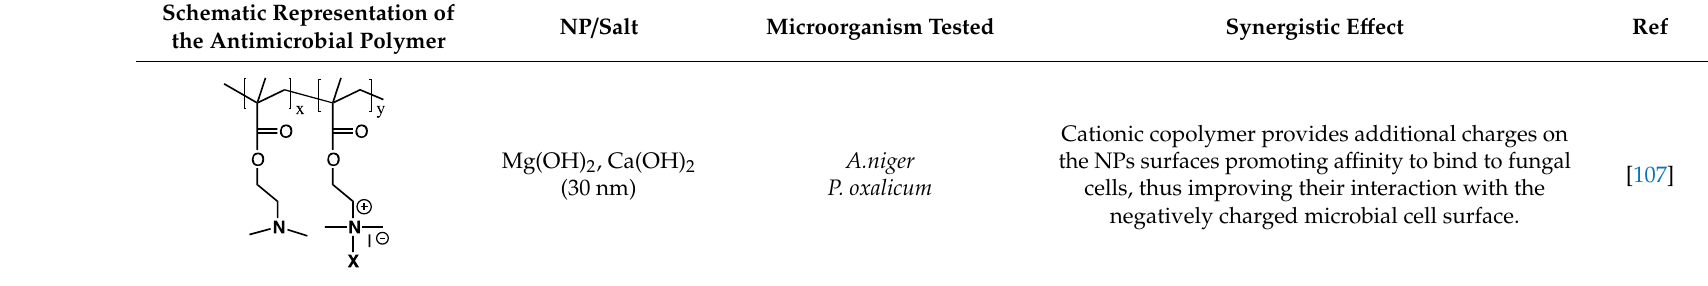
Figure 7. Illustration of the synthetic procedure of AgNPs embedded PTBAM nanofibers. Reproduced with permission from reference [99]. Copyright 2011